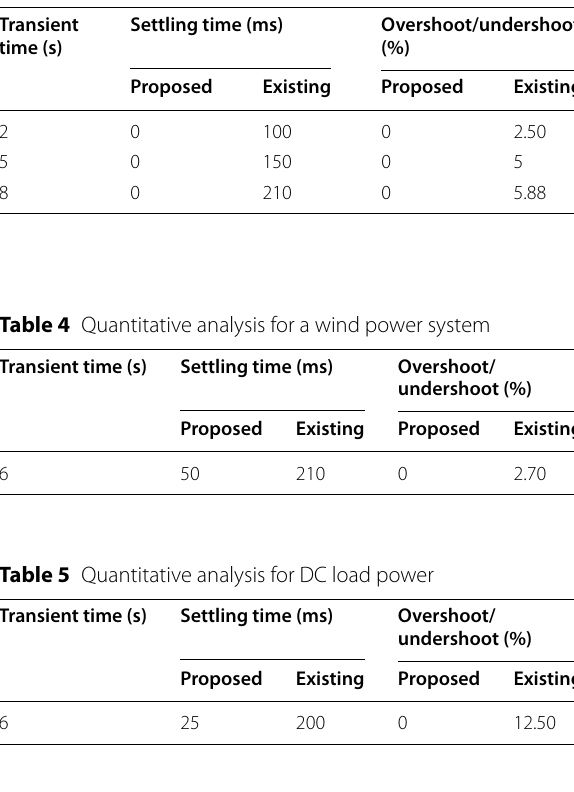
Table 3 Quantitative analysis for a solar PV unit